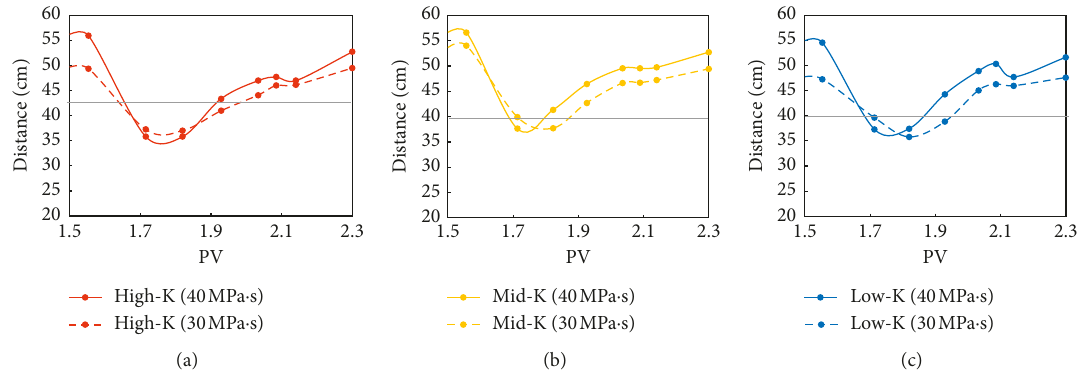
Figure 21: L of (a) high permeability layer, (b) middle permeability layer, and (c) low-permeability layer with different